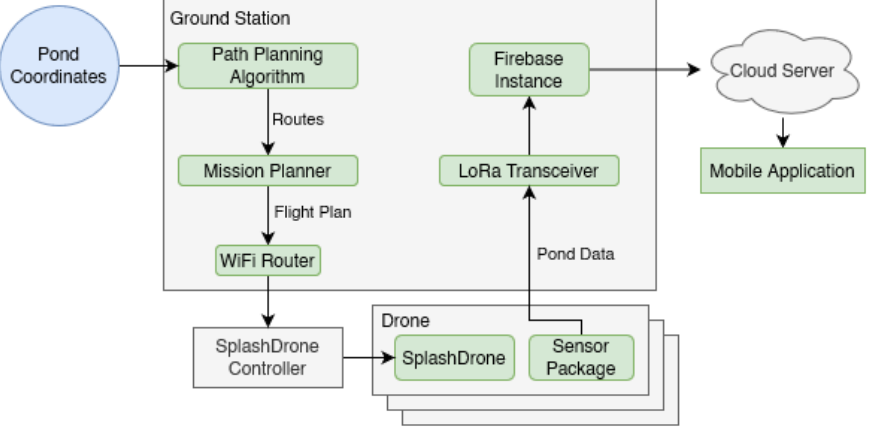
Figure 7. System diagram of the HAUCS path planning software and drone